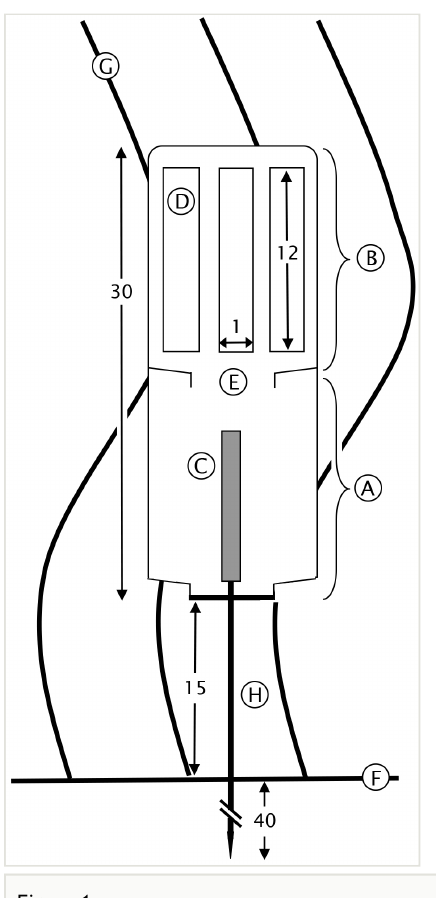
either fi rst or last author in order to check identi fi cation accuracy. Species names were matched against the authoritative, expert-driven World Register of Marine Species (WoRMS).